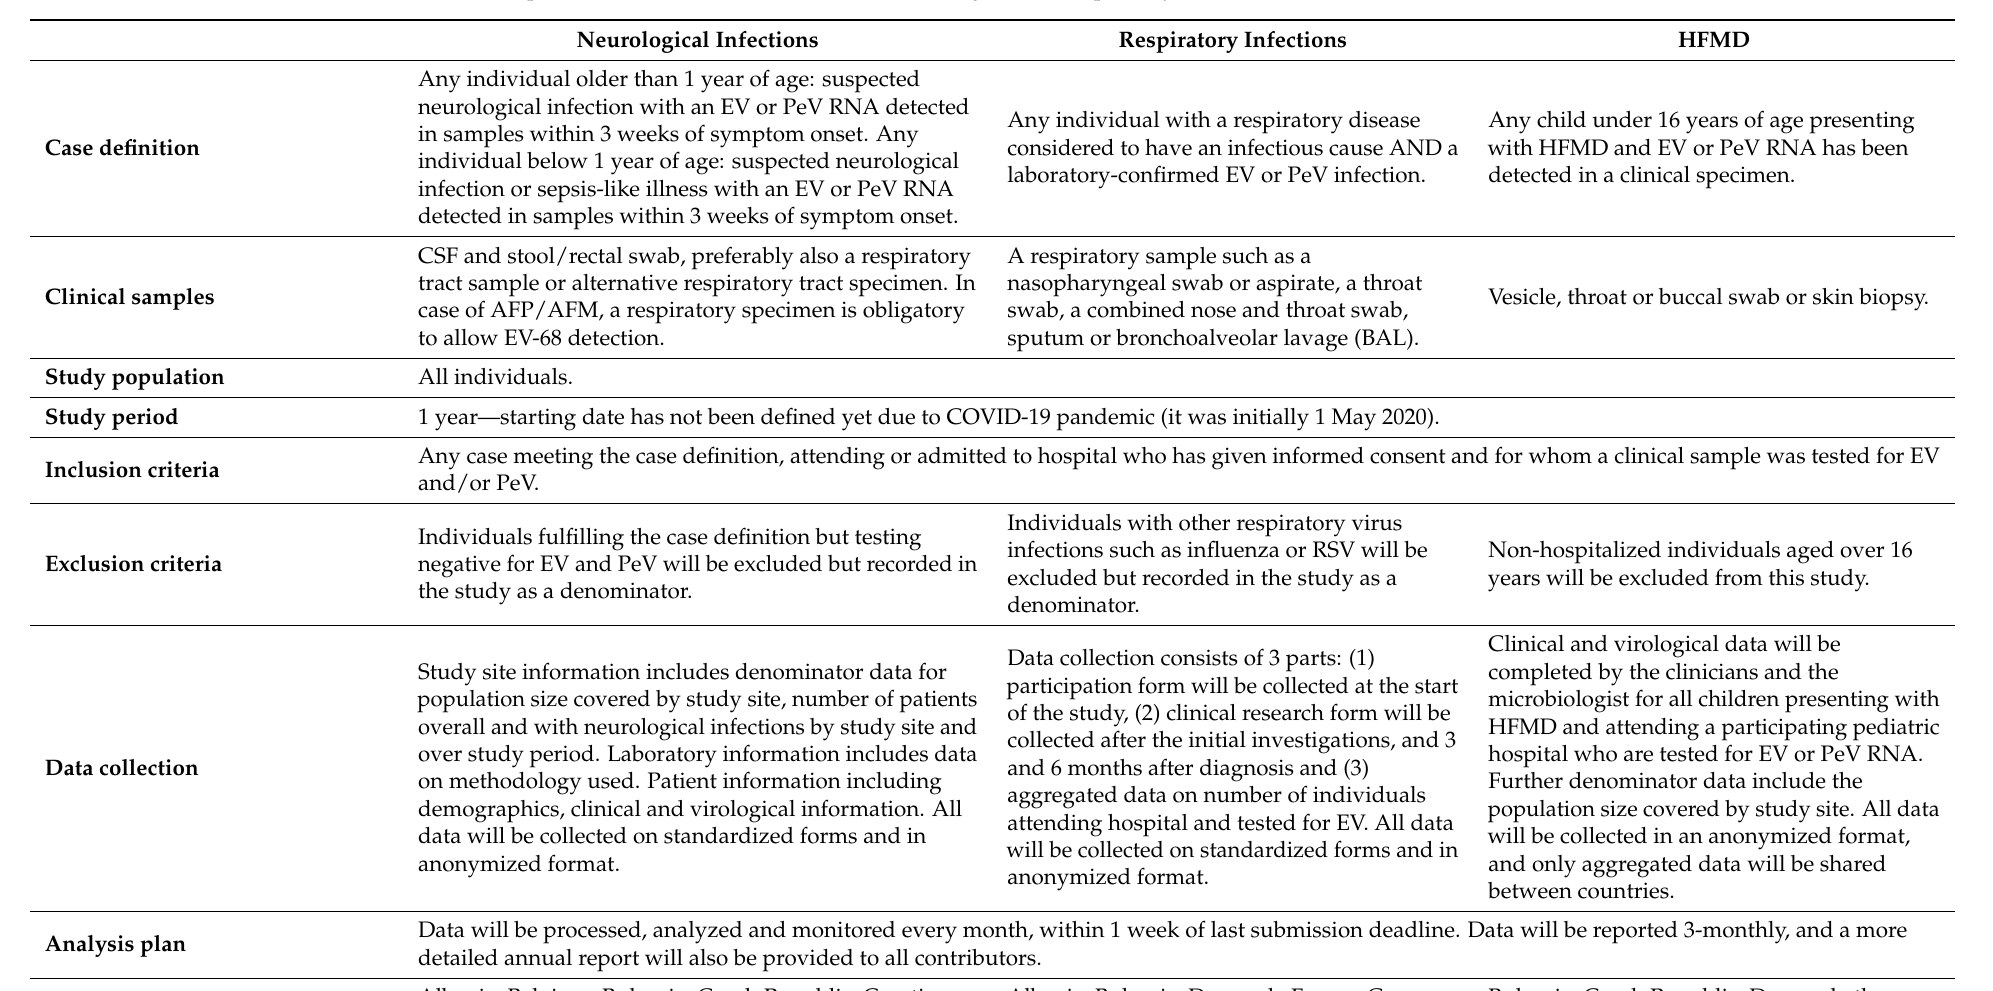
Table 1. Details of planned surveillance for HFMD and neurological and respiratory infections associated with EV or PeV